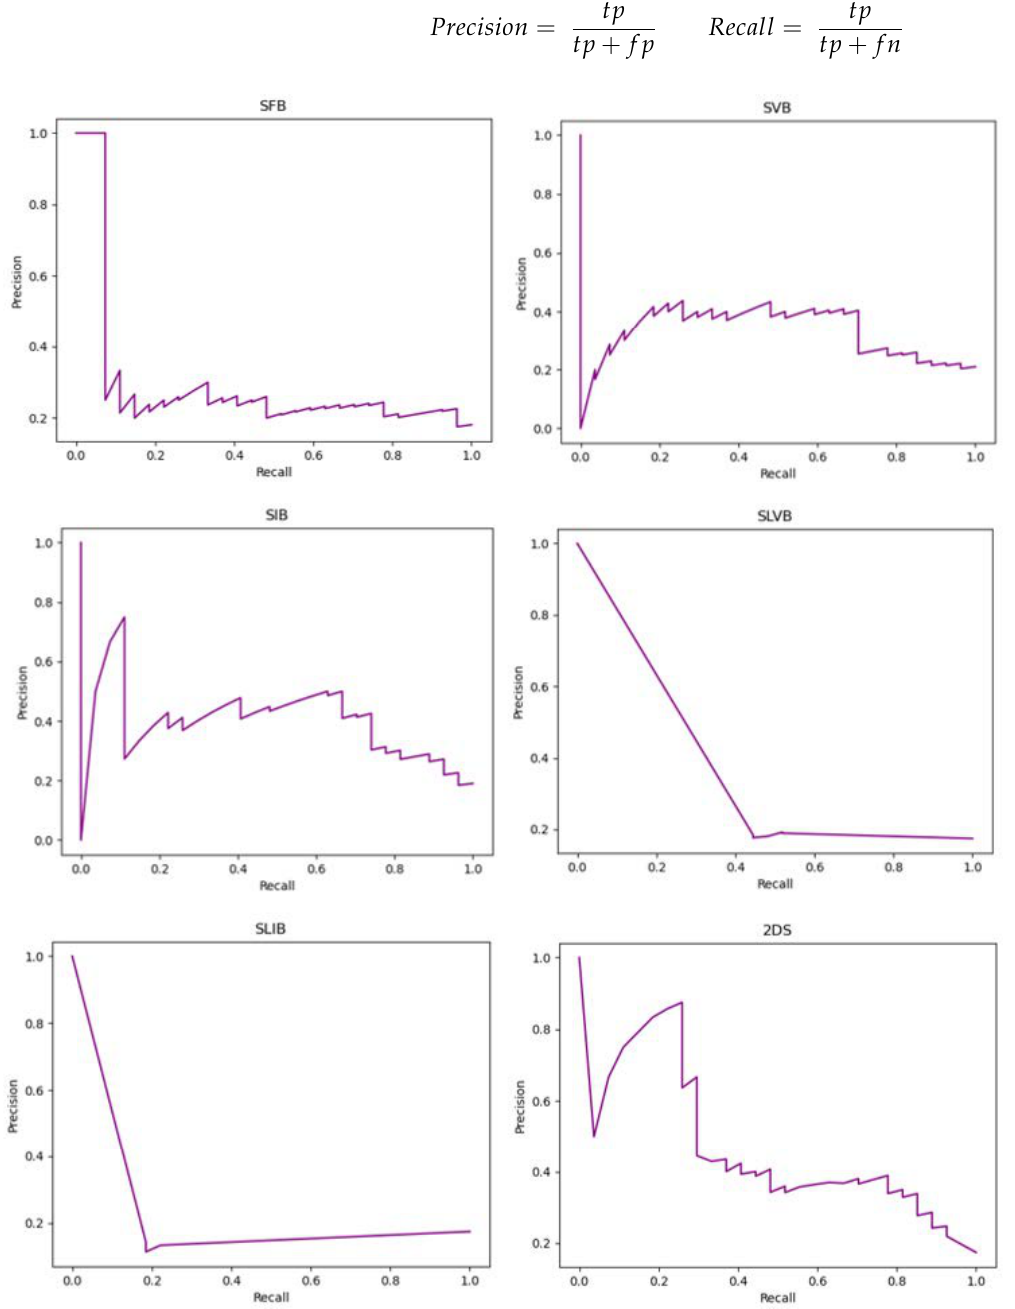
Figure 6. Precision-recall curves of the implemented experiments. The title of each plot suggests the tumor bounding option that is used.